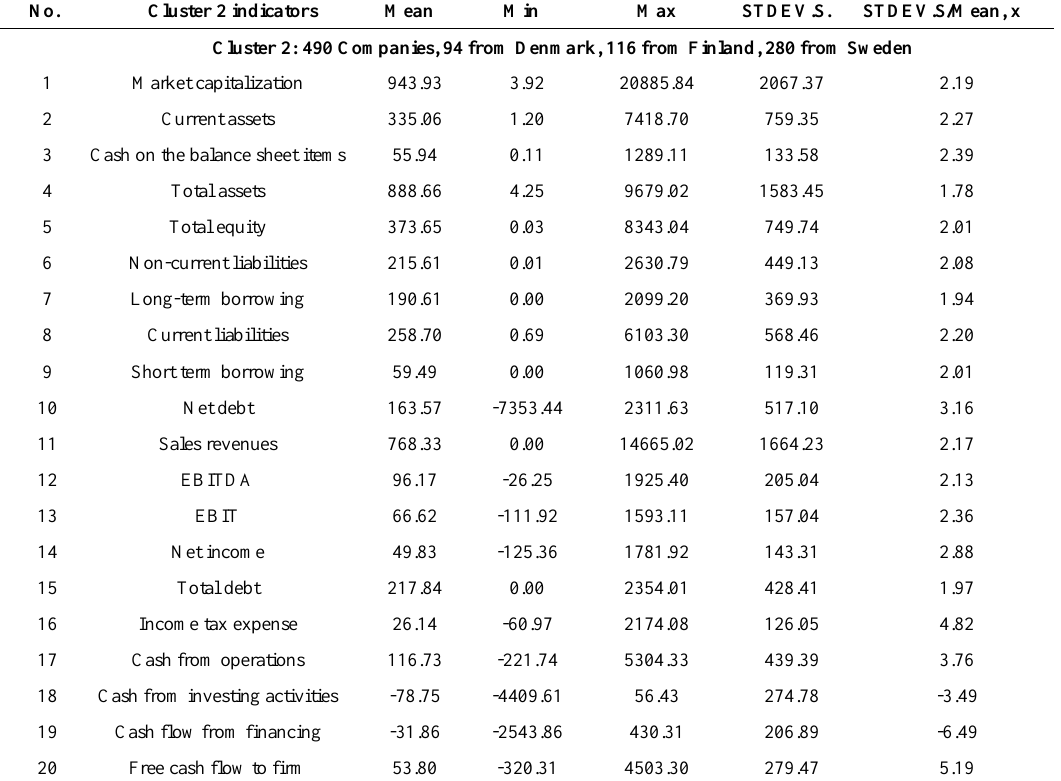
Table 7. Nordic countries stock market listed companies’ absolute value indicator description in the cluster 2.